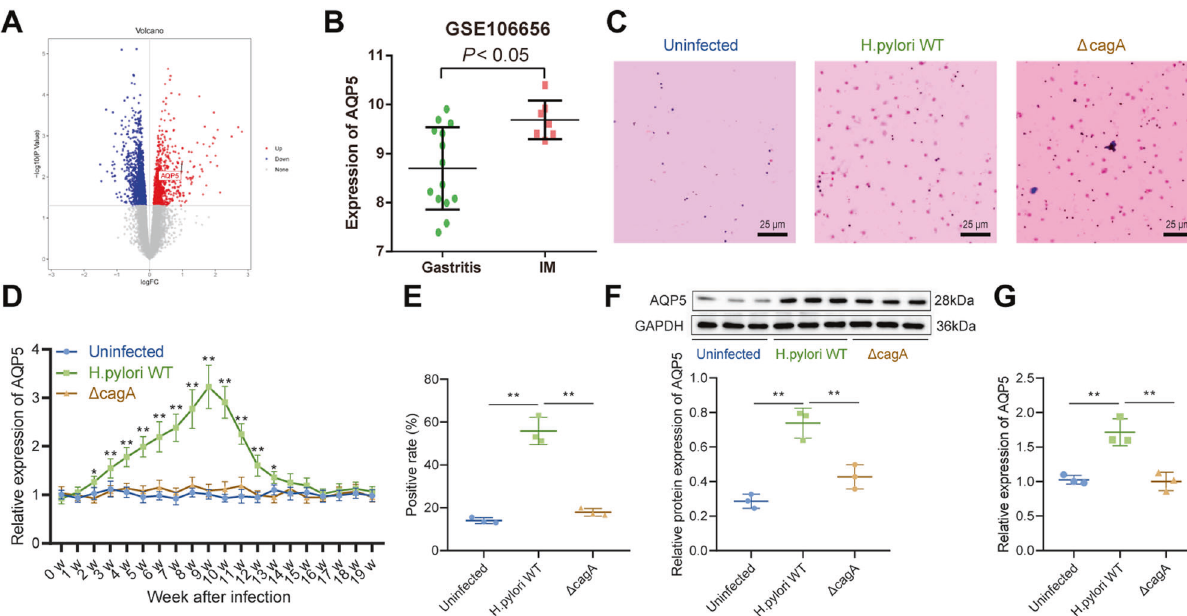
Fig. 1 H. pylori infection elevates AQP5 expression in gastric mucosa. A Volcano map of differentially expressed genes in microarray data GSE106656. Red represents upregulated genes and green represents downregulated genes with |log 2 FC | ≥ 1 and p < 0.05. B , AQP5 expression in 14 gastritis patients and 7 IM patients in microarray data GSE106656. C , H. pylori infection in mice detected by Giemsa staining. D , AQP5 mRNA level in mouse gastric mucosa determined by RT-qPCR ( n = 6). E , AQP5 protein level in mouse gastric mucosa determined by immunohistochemistry ( n = 3). F , AQP5 protein level in mouse isolated gastric mucosa determined by Western blot analysis ( n = 3). G , AQP5 mRNA level in mouse isolated gastric mucosa determined by RT-qPCR ( n = 3). * p < 0.05, ** p < 0.01. Data were shown as the mean ±